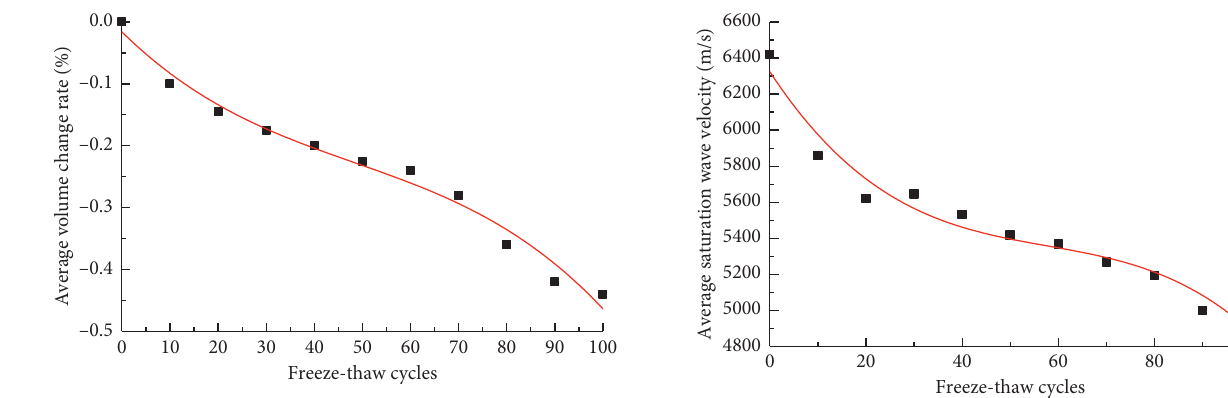
Figure 6: Average volume change rate after different freeze-thaw cycles.